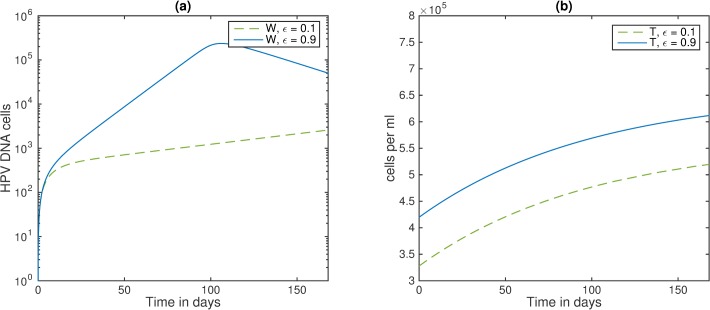
Effect of CD4+ T cell levels on HIV/HPV co-infections.(a) HPV W; (b) CD4+ T cells, T, as given by model (5) under cART. Here, ε = 0.1 (green dashed line), ε = 0.9 (blue solid line), εRT = 0.95, εPI = 0.5, and all other parameters are listed in Table 1. Initial conditions are T0 = 3.3x105 (green dashed line) or T0 = 4.5x105 (blue solid line) cells per ml, I0 = 2.4x105 cells per ml, V0 = 4.8x104 virions per ml, Y10 = 1 cells, E0 = 0.01 cells, Y20 = W0 = 0 and t = 0 is the start of cART.